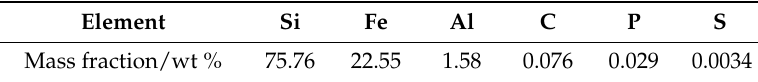
Table 1. Elemental composition of FeSi75Al2 alloy. Element